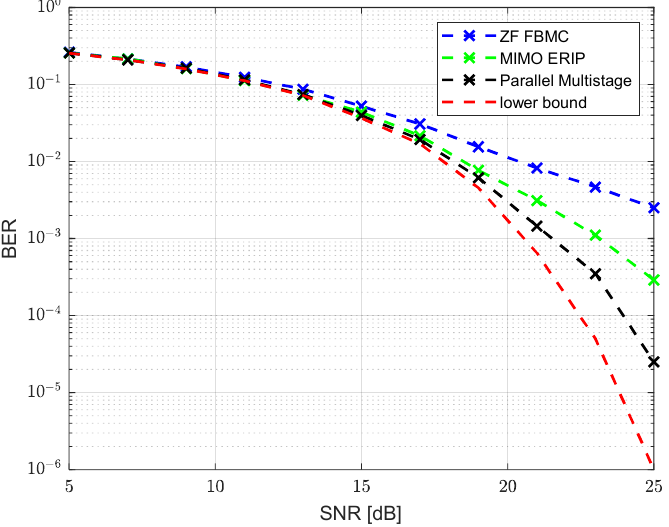
Figure 7. Uncoded BER performance versus SNR for HFHQ channel model.